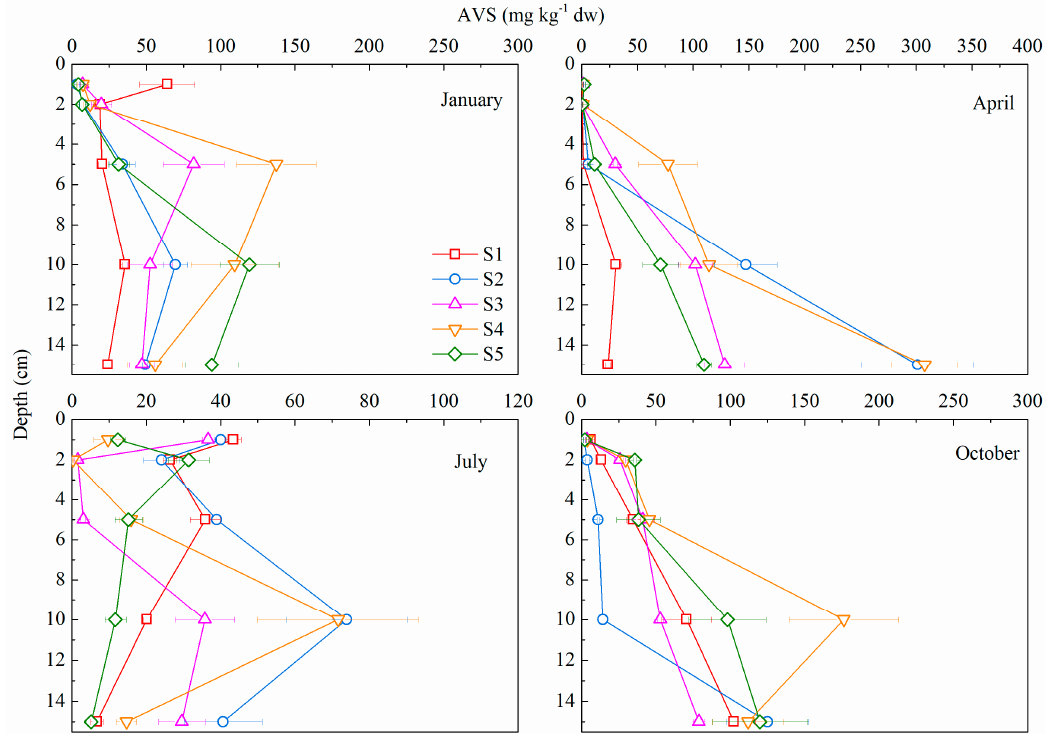
Figure 4. Acid volatile sulfide (AVS) profiles in the sediment during the field investigation period. Error bars indicate the standard deviation, n=3.